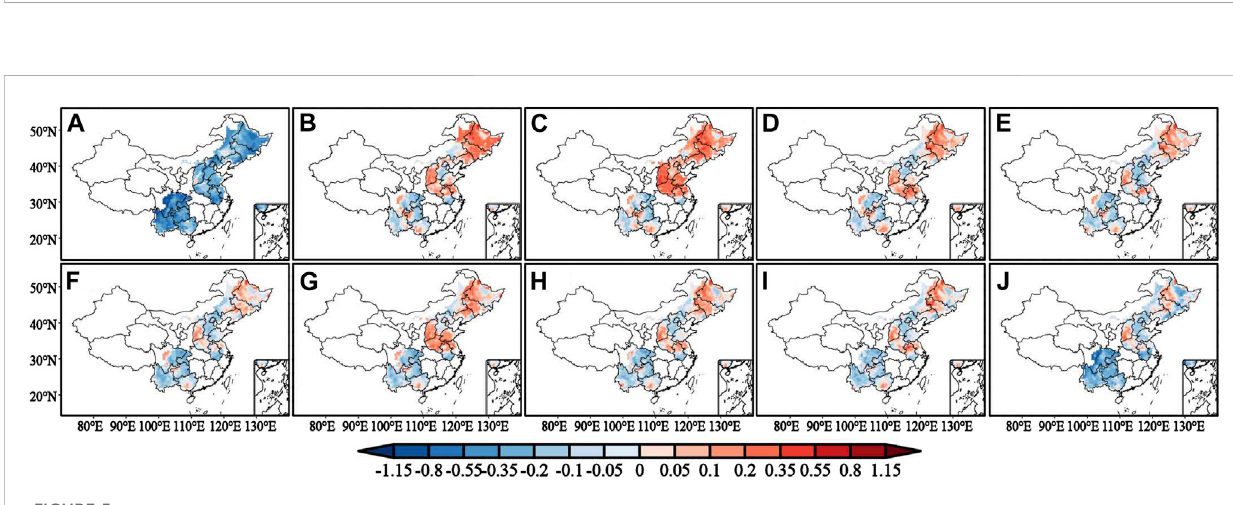
FIGURE 5 Contributions ofVPD and SM r withdifferentintensitiestomaizeyield in2010 – 2016. (A – E) ,theVPD contribution to maizeyield wasdivided into fi ve intervals from 0.1 kPa to 1.67 kPa (F – J) , same as in a-e, but driven by the root-zone soil moisture of maize (SM r ) from 0.2 cm 3 cm -3 to 0.42 cm 3 cm − 3